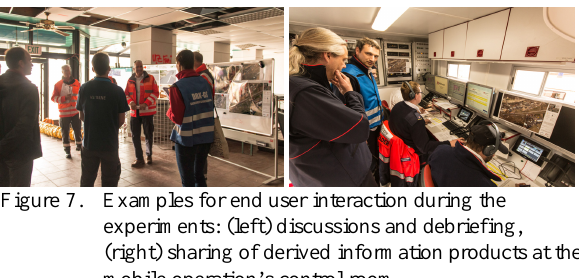
Figure 7. Examples for end user interaction during the experiments: (left) discussions and debriefing, (right) sharing of derived information products at the mobile operation’s control